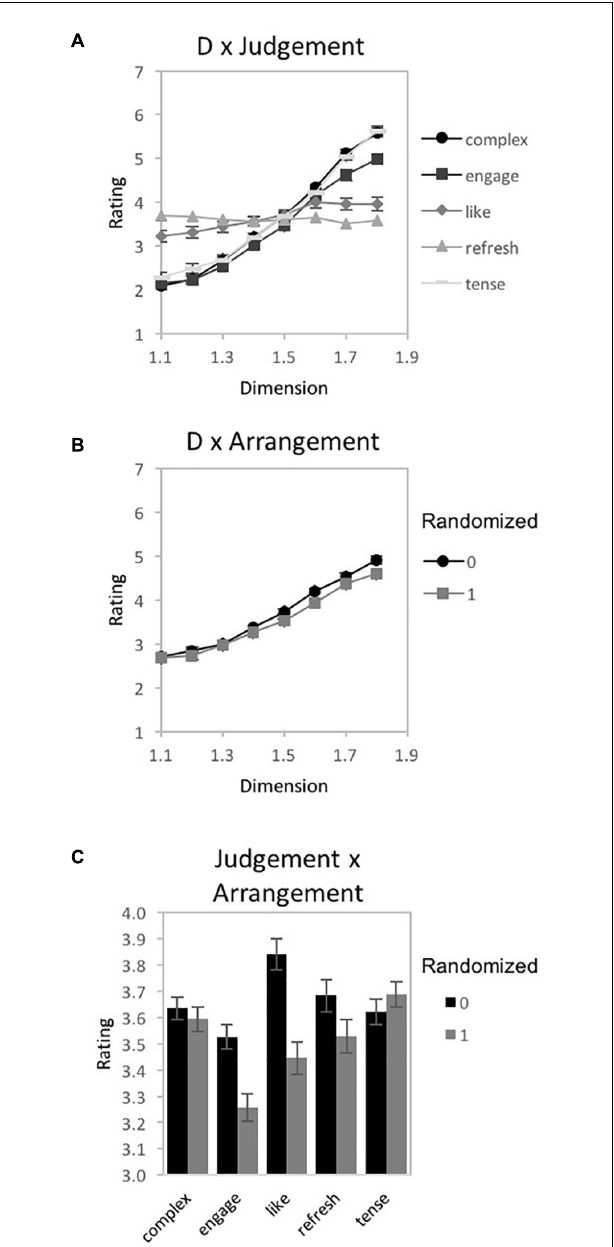
FIGURE 8 | Experiment 1B. Results for “global forest” fractal patterns using a bipolar rating scale. Results show significant 2-way interactions among the experiment’s 3 factors: fractal dimension ( D ), stimulus pattern arrangement (“0” for non-randomized and “1” for randomized), and judgment type (complex, engaging, liking, refreshing, and tense). Participant rating (on a scale from 1 to 10) is plotted as a function of (A) D -value and different judgment conditions, (B) D -value and different pattern arrangements, and (C) judgment and randomization conditions (error bars represent standard error).